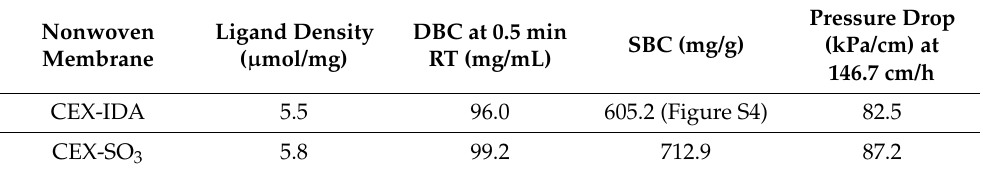
Table 1. Comparison of CEX-IDA and CEX-SO 3 membranes 1 prepared by coupling of ligands for 7 h at 80 ◦